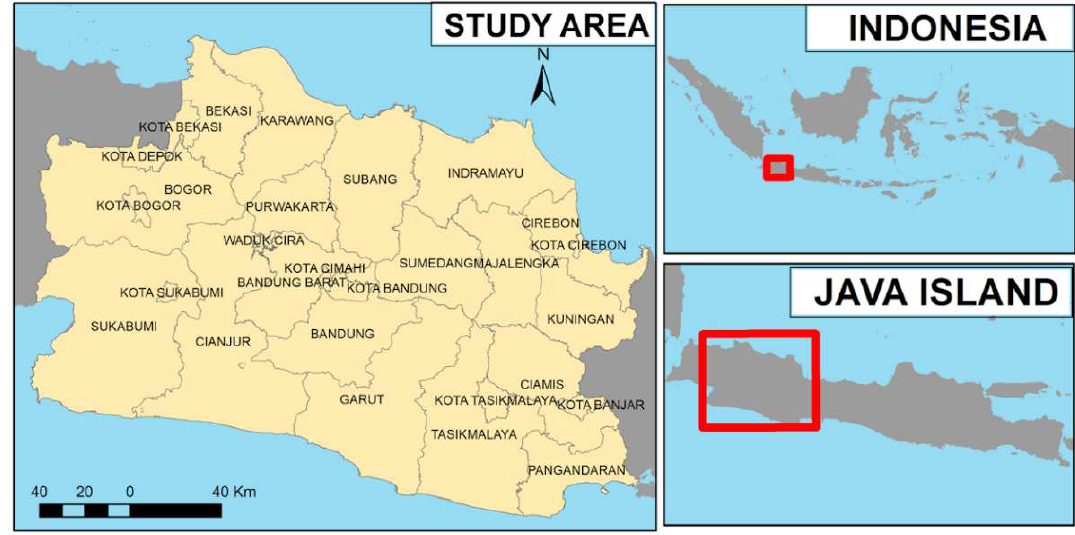
Figure 1. West Java Province as the study area.